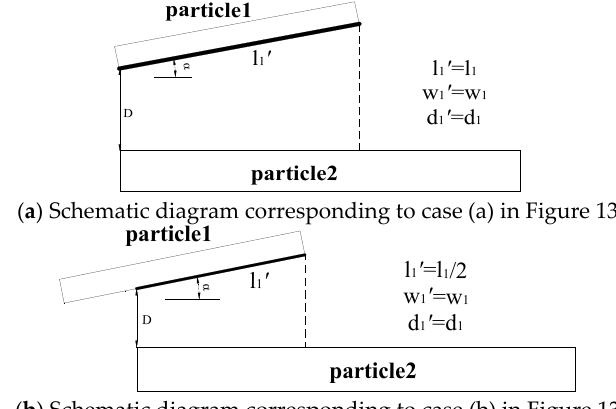
( b ) Schematic diagram corresponding to case (b) in Figure 13 Figure 15. Schematic diagram of the projection step treating plate2 as the wall. Minerals 2020 , 10 , x FOR PEER REVIEW